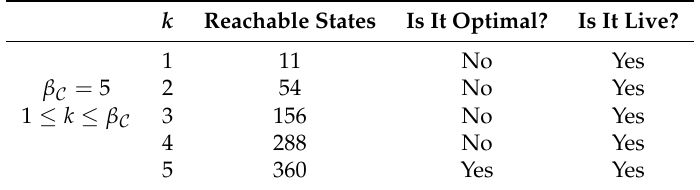
Figure 10. A controlled Petri net model ( N c , M c Table 2. Behavior of the controlled Petri net model from the minimal to maximum initial